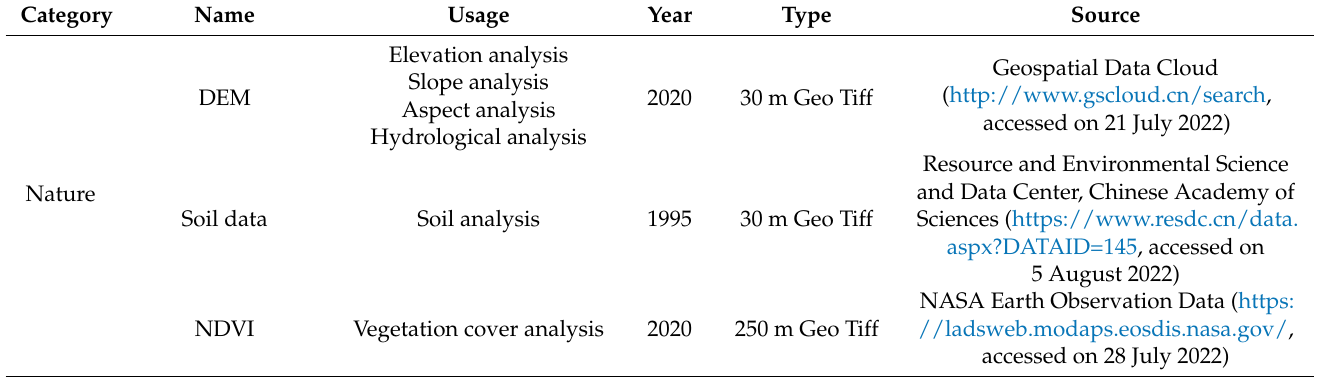
Table 1. Description of the datasets utilized in this study.